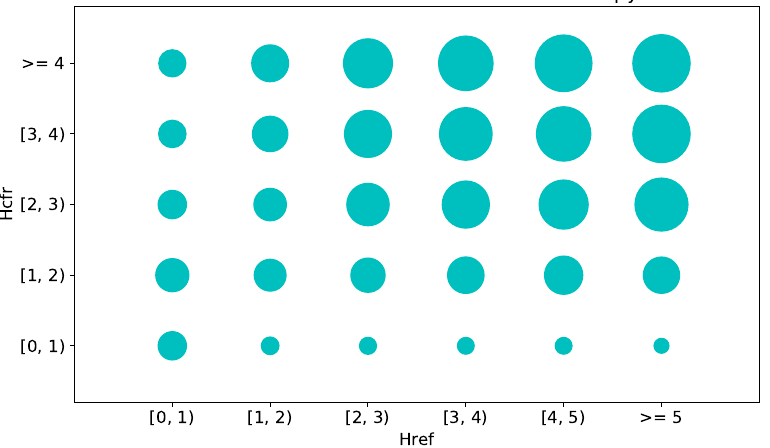
Figure 6. Ratio of successful Mann–Whitney U tests while comparing neurons belonging to different entropy ranges. When tests succeed the classification behavior of neuron N ref can be approximated by defining a threshold on the activation levels of neuron N cf